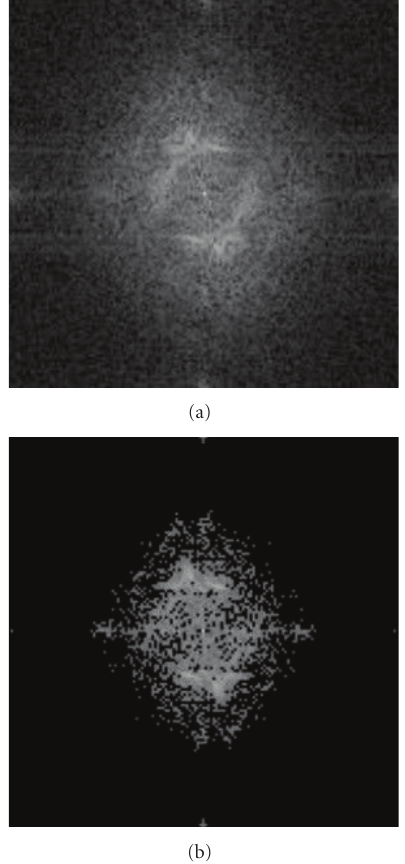
Figure 27: Phase image (a) and phase image with most significant frequencies